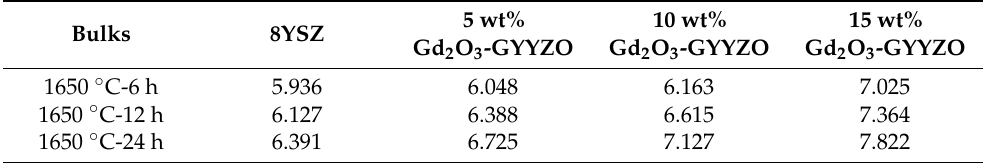
Table 6. Fracture toughness of the sintered bulks/MPa · m 0.5